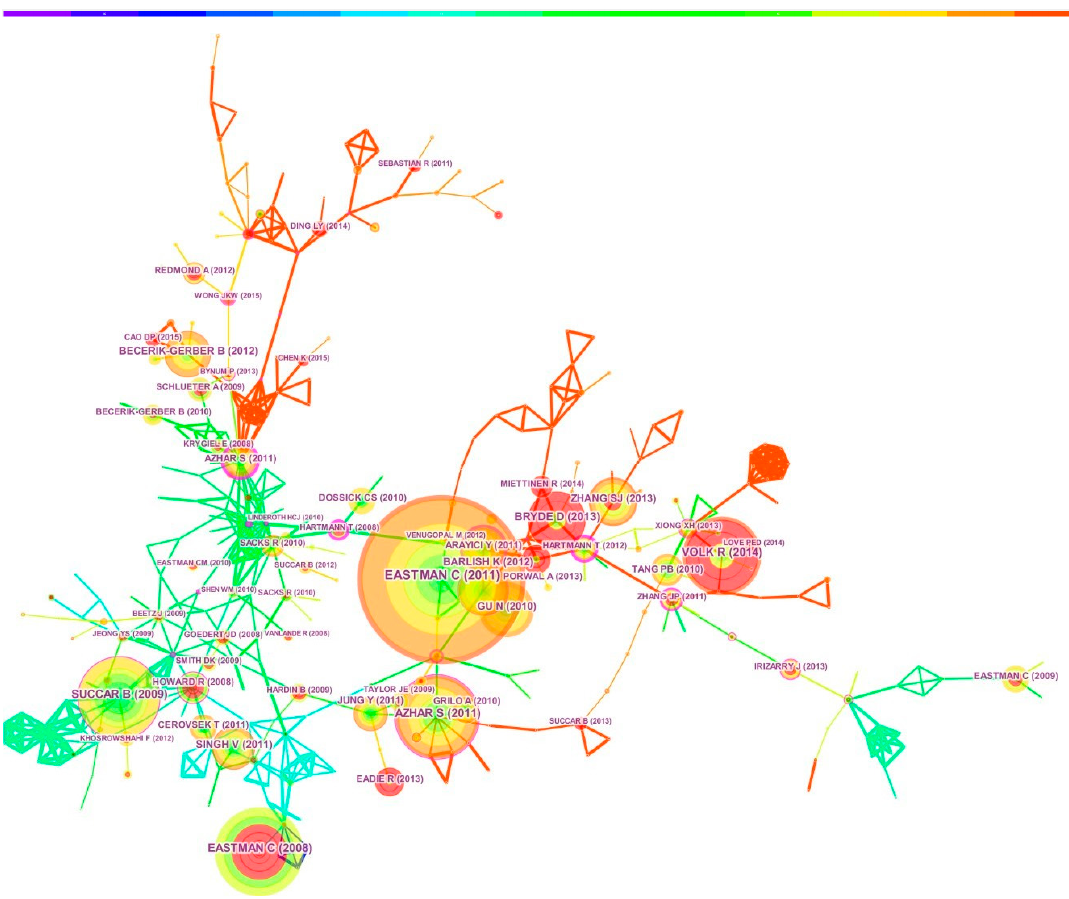
Figure 12. Document co-citation network.